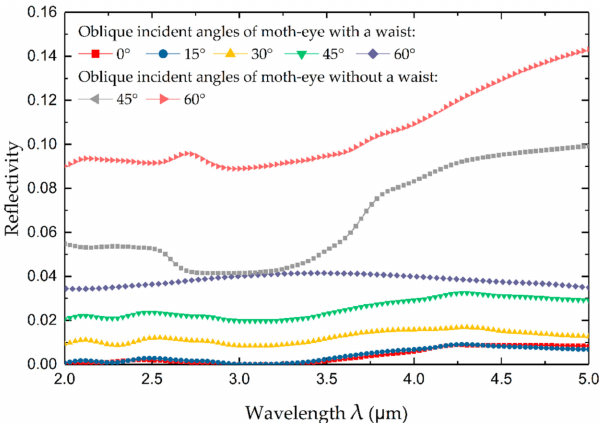
Figure 5. The reflection characteristics of the moth-eye structure with a waist array for oblique incident angles, comparing with the moth-eye structure without a